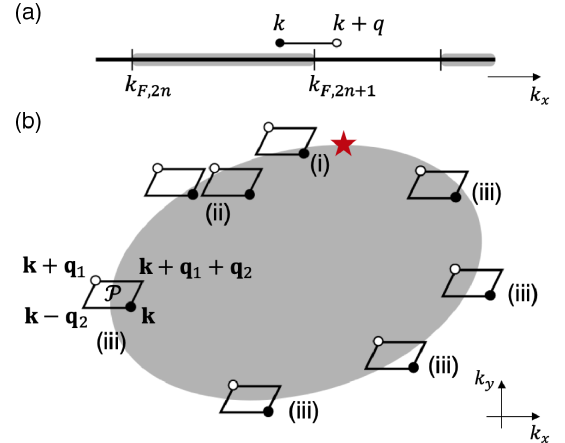
FIG. 11. Geometric proof for the universal behavior of density correlation in (a) D ¼ 1 and in (b) D ¼ 2 . The shaded region represents the filled Fermi sea. The integral involved in s be evaluated pictorially. For D ¼ 1 , it is evaluated from the overlap between the interval ð k; k þ q Þ and the 1D Fermi sea, with net contribution arising near Fermi points. For D ¼ 2 , the integral is evaluated from the overlap between the parallelogram P and the 2D Fermi sea. By considering various placements of P , labeled by (i) – (iii), we conclude that the net contribution arises near the Fermi surface critical point marked by the red star. See the main text for details of the proof.